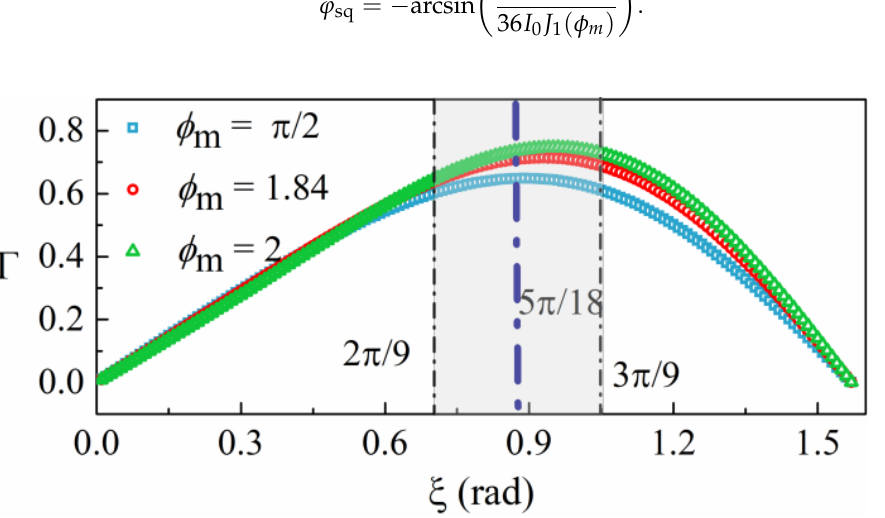
Figure 3. Optimized picking interval for the elimination of the synchronous sampling delay, τ , at different modulation amplitudes.